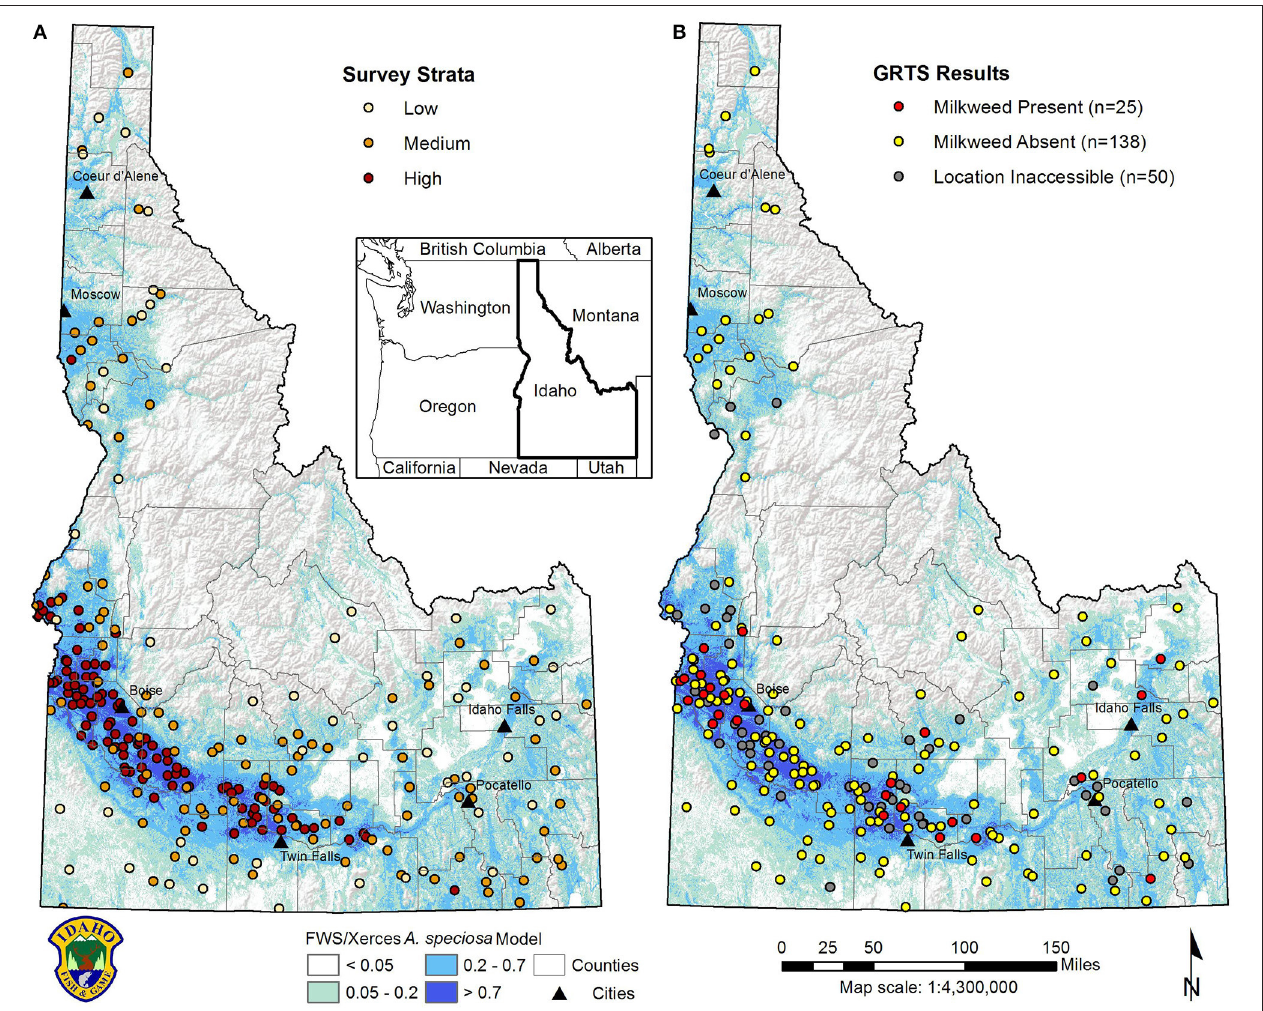
FIGURE 2 | (A) GRTS sampling framework for milkweed and monarch surveys in Idaho stratified by high, medium, and low relative habitat suitability for showy milkweed ( Asclepias speciosa ) based on preliminary model developed by USFWS and Xerces (2016); (B) results of GRTS cell surveys in Idaho,